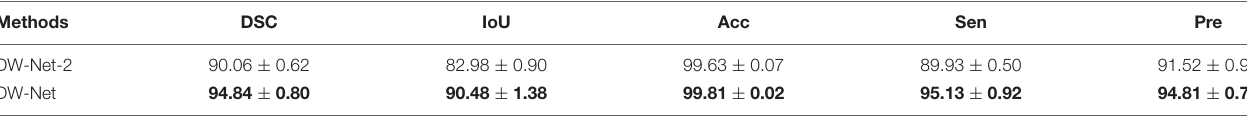
FIGURE 8 | Value of the learnable parameter α i , 2 j + k during training. TABLE 4 | Choroid neovascularization (CNV) segmentation experiments without retinal layers (mean ±